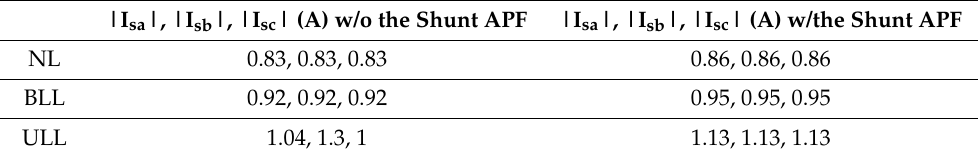
Table 3. The magnitudes of Is without and with the shunt APF.